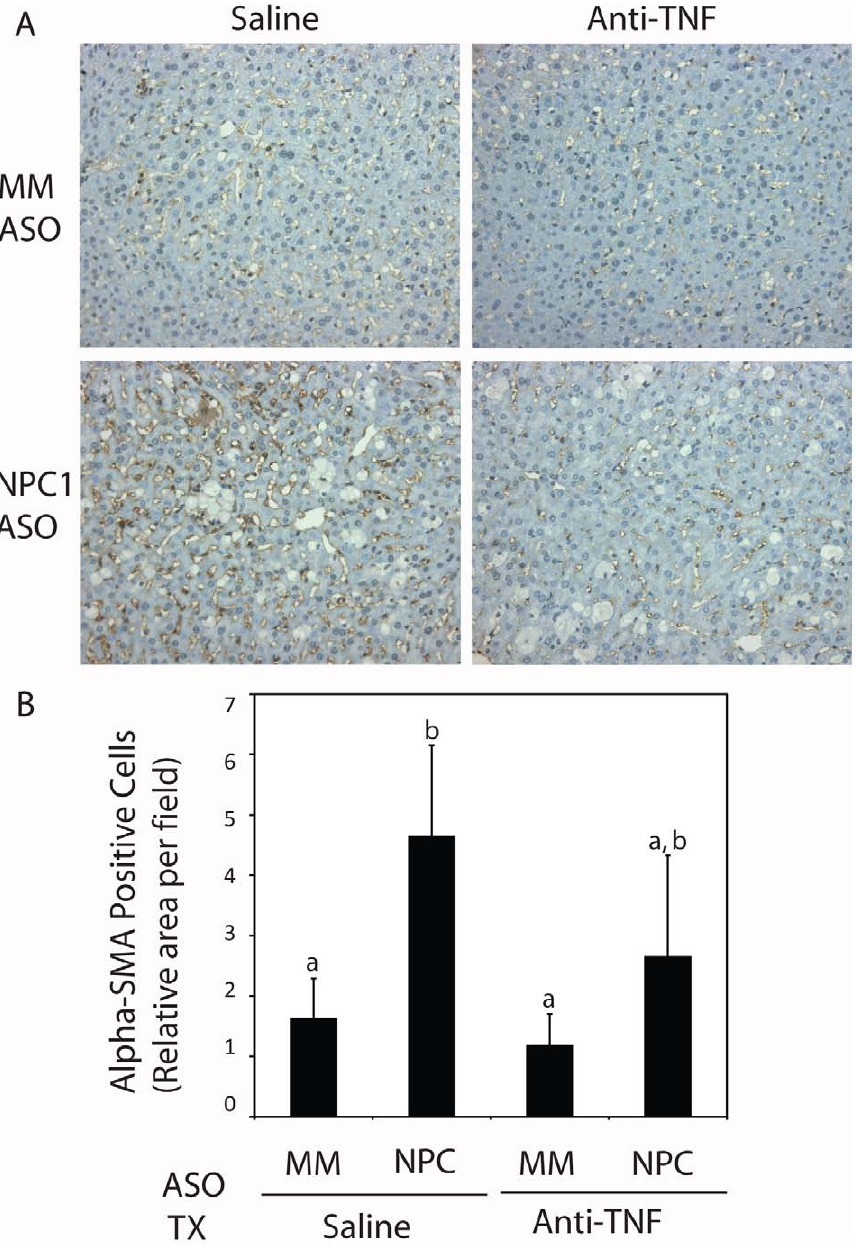
Figure 5. Stellate cell activation after NPC1 knockdown and anti-TNF treatment. Liver sections from mice injected for 9 weeks with mismatched (MM) and NPC1-specific ASOs and subjected to treatment with saline or anti-TNF were subjected to a -smooth muscle actin immunohistochemistry (A). Immunohistochemical reaction product was quantified (B). Each bar represents the mean 6 SD relative area of brown reaction product per field from 5 animals in each treatment group. The lettering (a, b) shows statistically dissimilar groups. Samples with two letters represent values that are intermediate to the statistical groups and are thus not considered significantly different from either